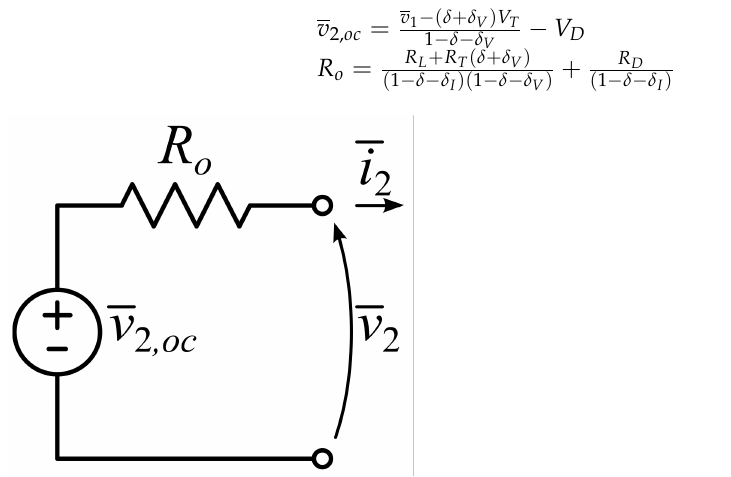
Figure 8. Equivalent circuit model of a DC–DC converter considering Joule and conduction losses in the semiconductors (average